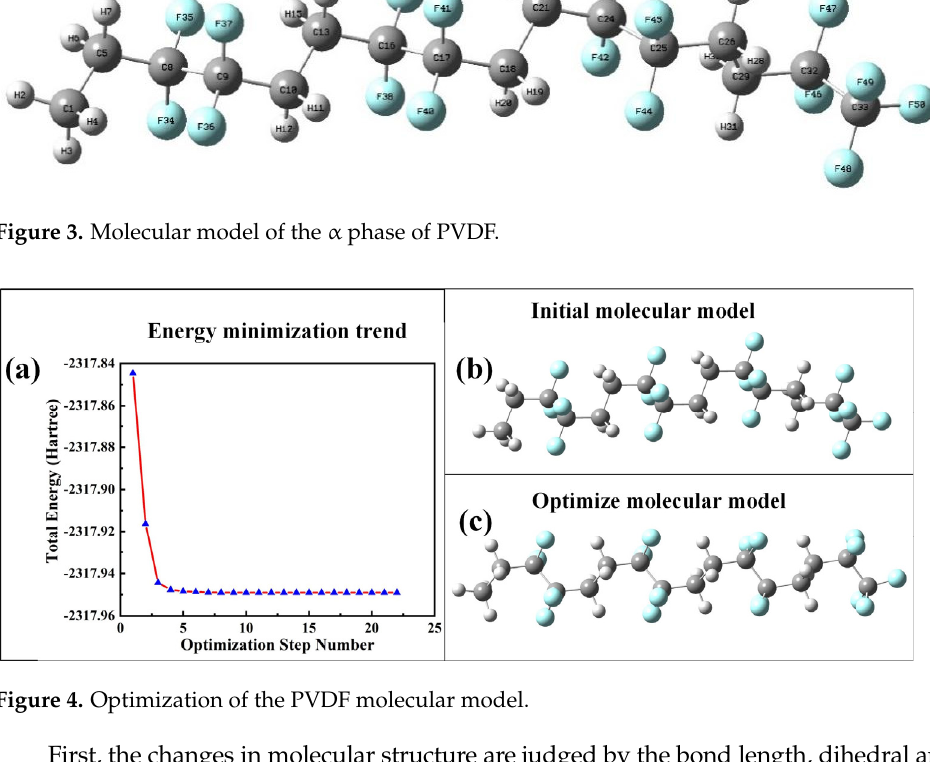
Figure 4. Optimization of the PVDF molecular model.